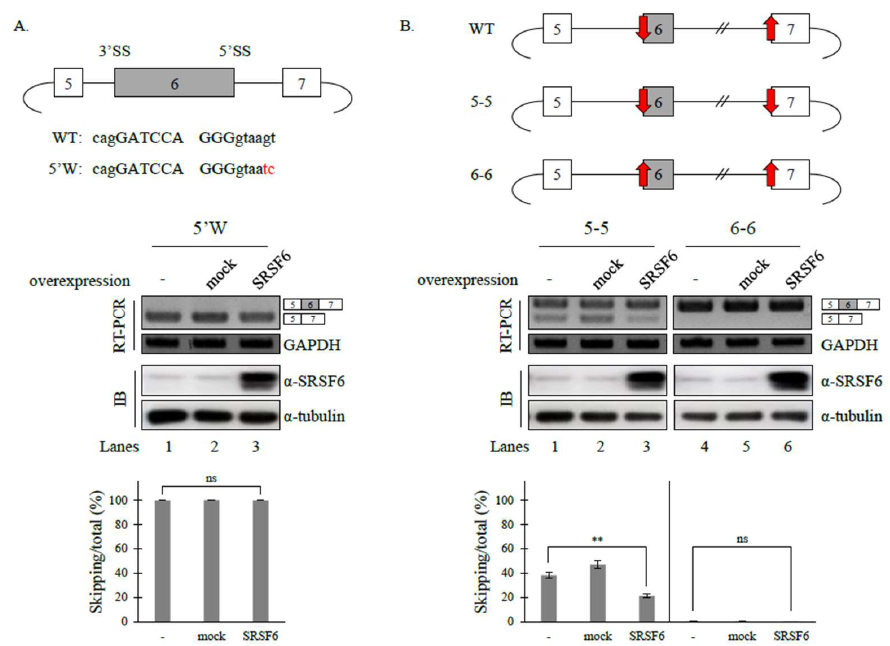
Figure 3. 5′ splice-site (5′SS), but not 3′ splice-site (3′SS), strength affects SRSF6 function on Fas pre-mRNA splicing. ( A ) (Upper) Schematic representation of the 5′W minigene. Mutated sequences are shown in red. (Middle) RT-PCR analysis of the 5′W minigene with RNAs from untreated, empty vector-treated, and SRSF6-overexpressed cells with GAPDH as a loading control. Immunoblotting of these cells with anti-SRSF6 antibody was also performed with α-tubulin as a loading control. (Lower) Statistical analysis graphs of RT-PCR with p values. ( B ) (Upper) Schematic representations of WT, 5-5, and 6-6 minigenes. Stronger and weaker 3′ splice-sites are indicated by upper and lower arrows, respectively. (Middle) RT-PCR analysis 5-5 and 6-6 minigenes with RNAs from untreated, empty vector-treated and SRSF6-overexpressed cells. (Lower) Statistical analysis graphs of RT-PCR with p values. Standard deviations (SD) calculated from three independent experiments are indicated by error bars: ** p < 0.01, ns p > 0.05. Uncropped figures are shown in Supplementary Figure S3.